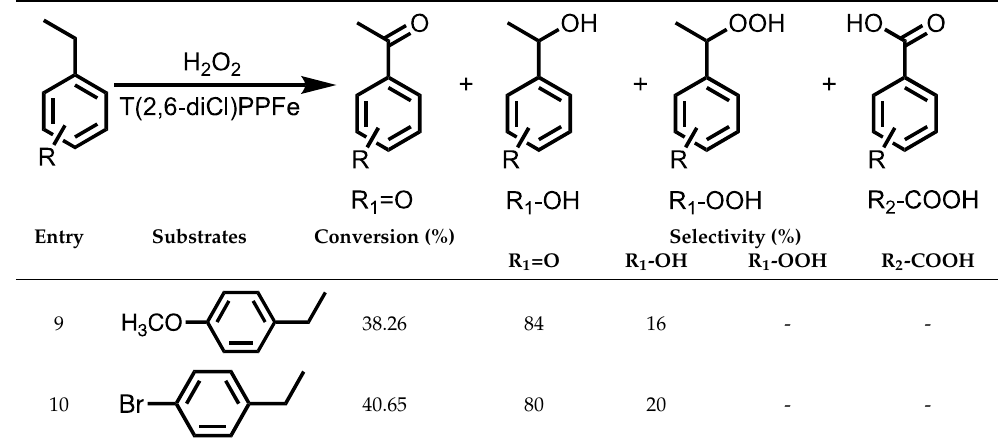
Table 7. Ethylbenzene and its derivates oxygenation employing H 2 O 2 catalyzed by T(2,6-diCl)PPFe Table 7. Cont. a .